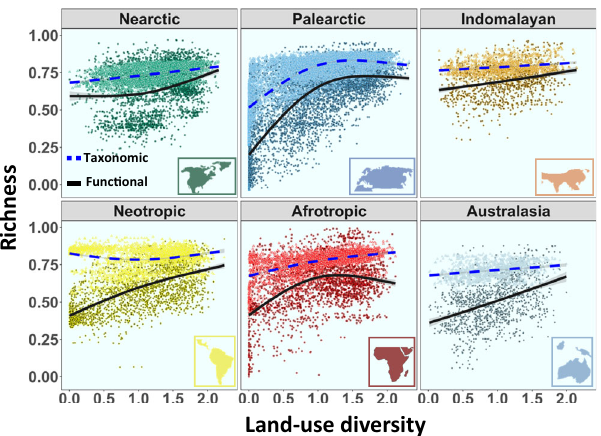
Fig.2|Effectofregionalland-usediversityonbirdrichness. Additivemodel fi tto partial residuals, showing the association between land-use diversity (Shannon index) and taxonomic richness (blue dashed line) and functional richness (black solid line) across the six main biogeographic realms. Each point represents a grid cell of one-degree size. Taxonomic and functional richness were standardized to themaximumvalueobserved.Linesshowthemodel fi tandlineshadowsrepresent 95% con fi dence intervals. Nearctic: n =2630 grid cells. Neotropic: n =2262 grid cells. Palearctic: n =6123 grid cells. Afrotropic: n =2466 grid cells. Australasia: n =1212 grid cells. Indomalaya: n =1087 grid cells. Source data are provided as a Source Data fi le. Biogeographic realm outlines were modi fi ed from https:// freesvg.org.